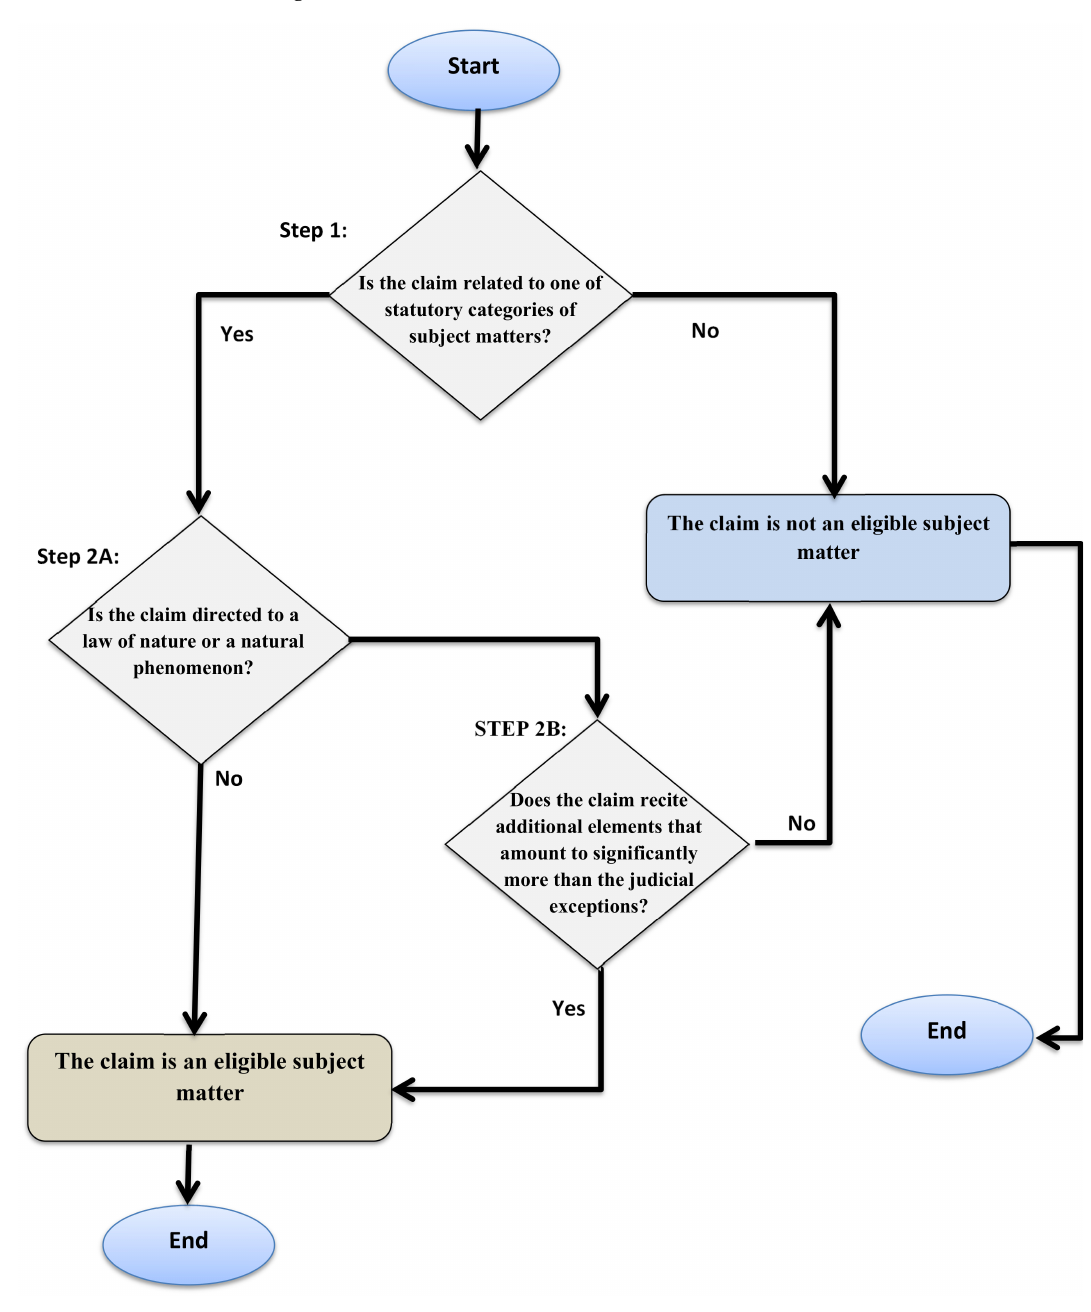
Figure 1. The USPTO’s nature exclusion